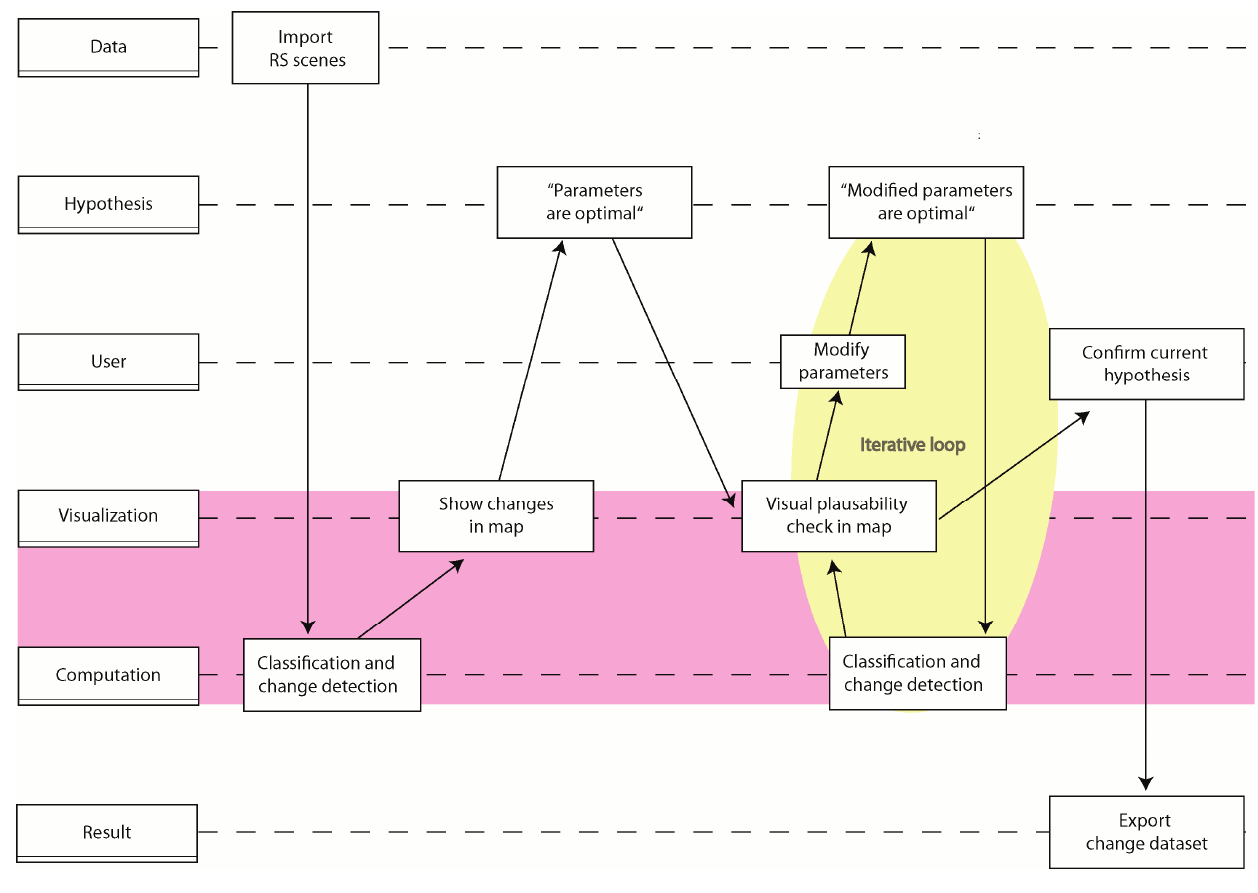
Figure 4. Workflow: Optimizing change